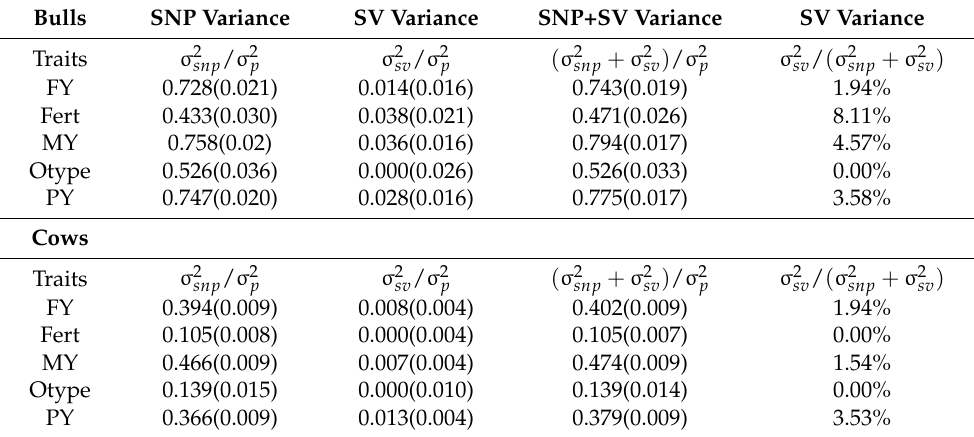
Table 4. Proportion of SNP and SV variance components in bulls and cows for fat, milk, protein yield, fertility and overall type traits using model 2.